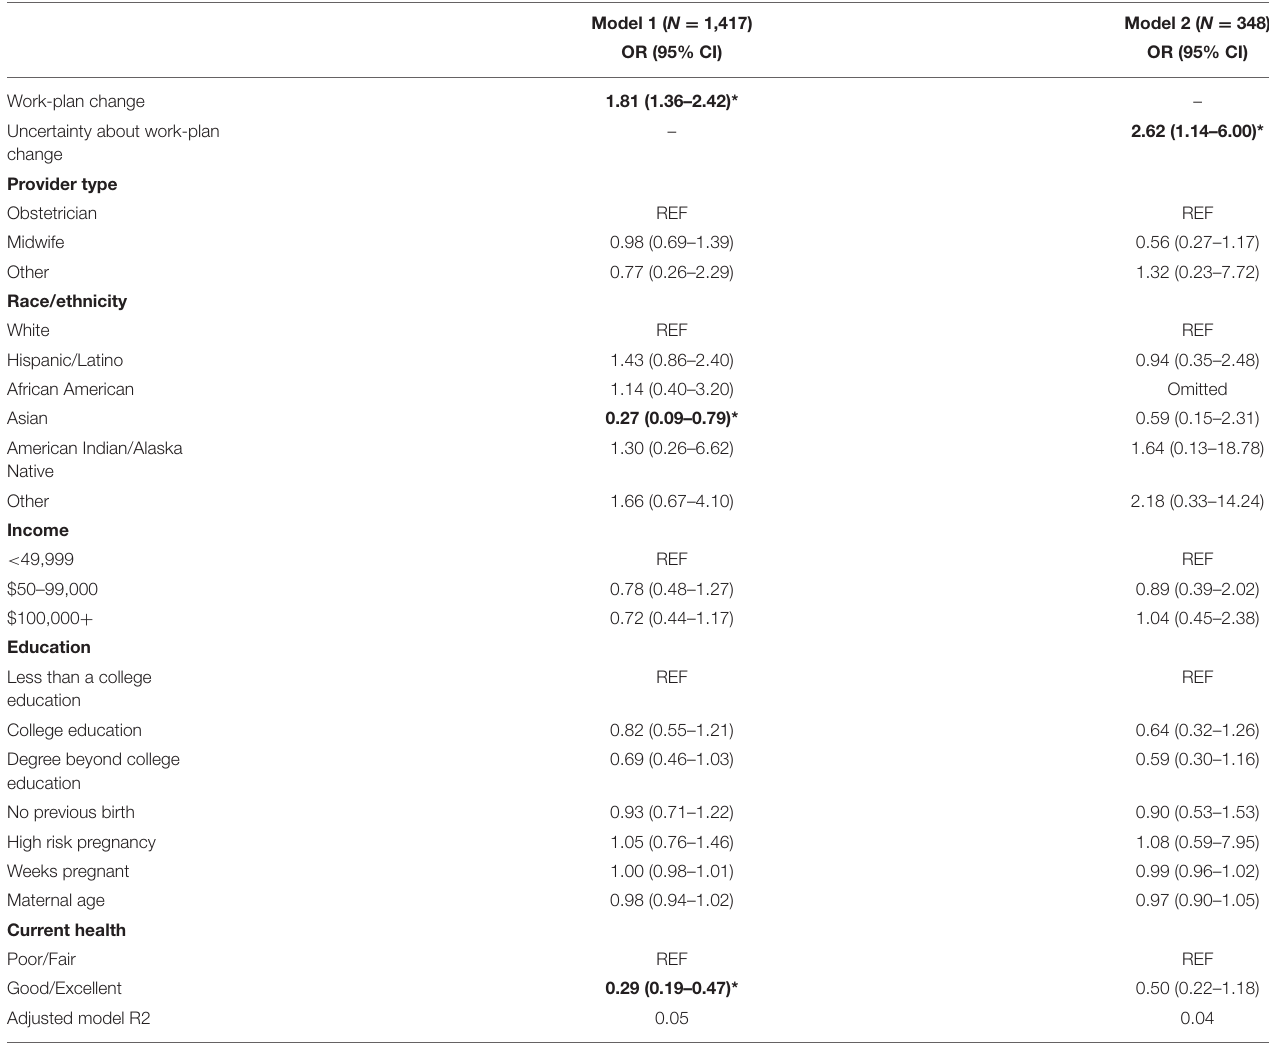
TABLE 2 | Regression results for association between work-plan changes and clinically significant depression (Model 1) and uncertainty about work-plan changes and depression (Model